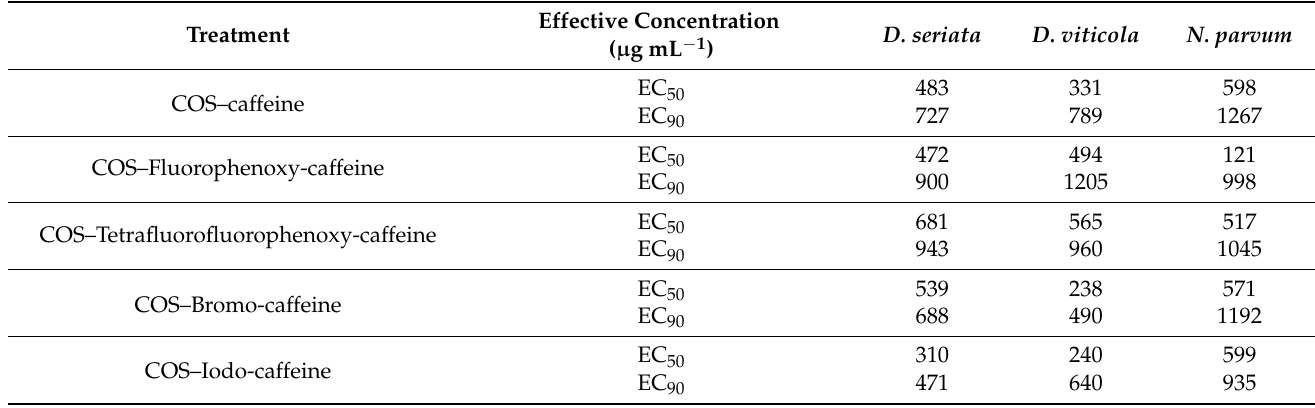
Table 6. Effective concentration values for the COS binary and ternary conjugate complexes against the three grapevine